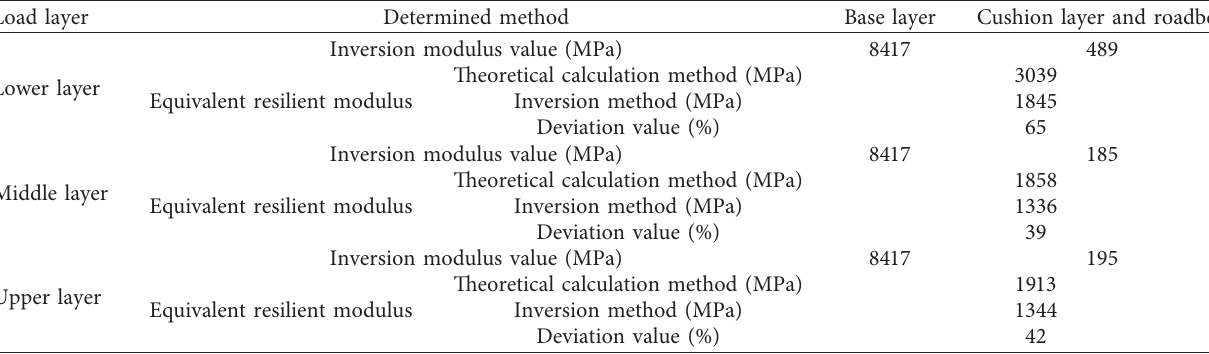
Table 6: Calculation of equivalent resilient modulus of the top surface of structure S1.